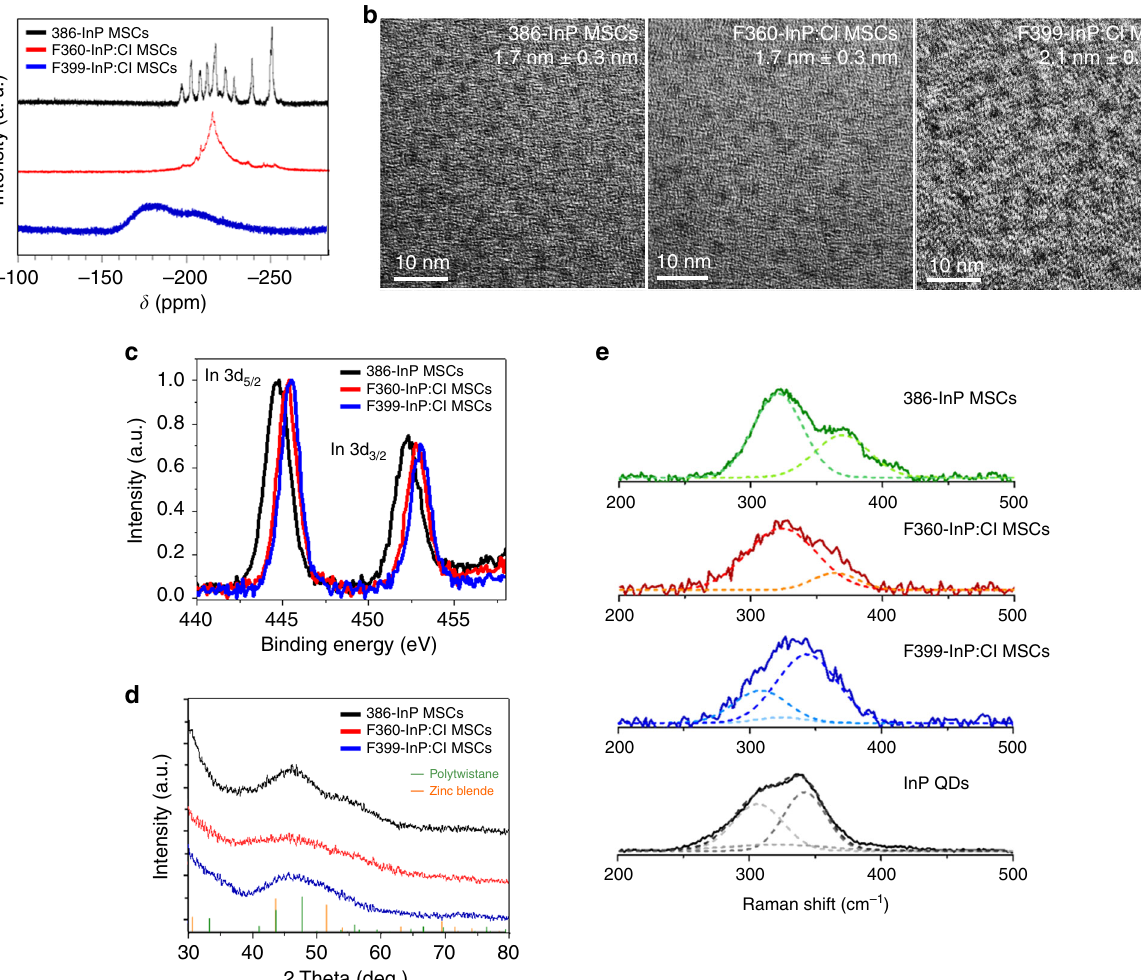
Fig. 5 Structural characterizations of InP:Cl MSCs. a 31 P{ 1 H} NMR, b TEM images, c In 3d XPS, and d XRD patterns of 386-MA InP MSCs, F360-InP:Cl MSCs, and F399-InP:Cl MSCs. JCPDS diffraction fi le No. 32-0452 was used for zinc-blende InP. The XRD pattern of polytwistane phase was obtained from a previous publication 25 . e Raman spectra of 386-InP MSCs, F360-InP:Cl MSCs, F399-InP:Cl MSCs, and InP QDs with zinc-blend structure. All Raman spectra was fi tted with two and three overlapping Gaussian